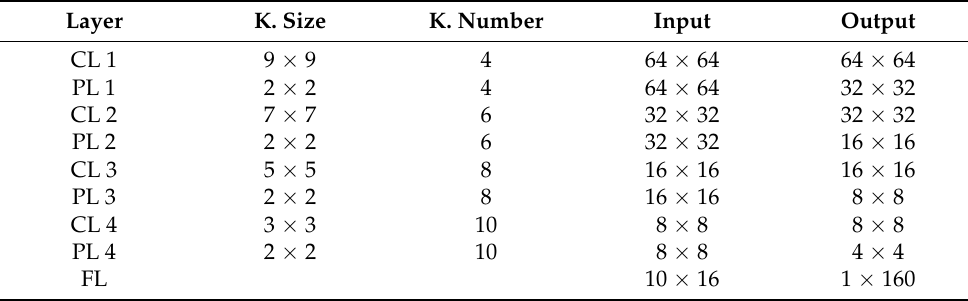
Table 1. Feature map architecture with a profound receptive field (A1). Layer K.